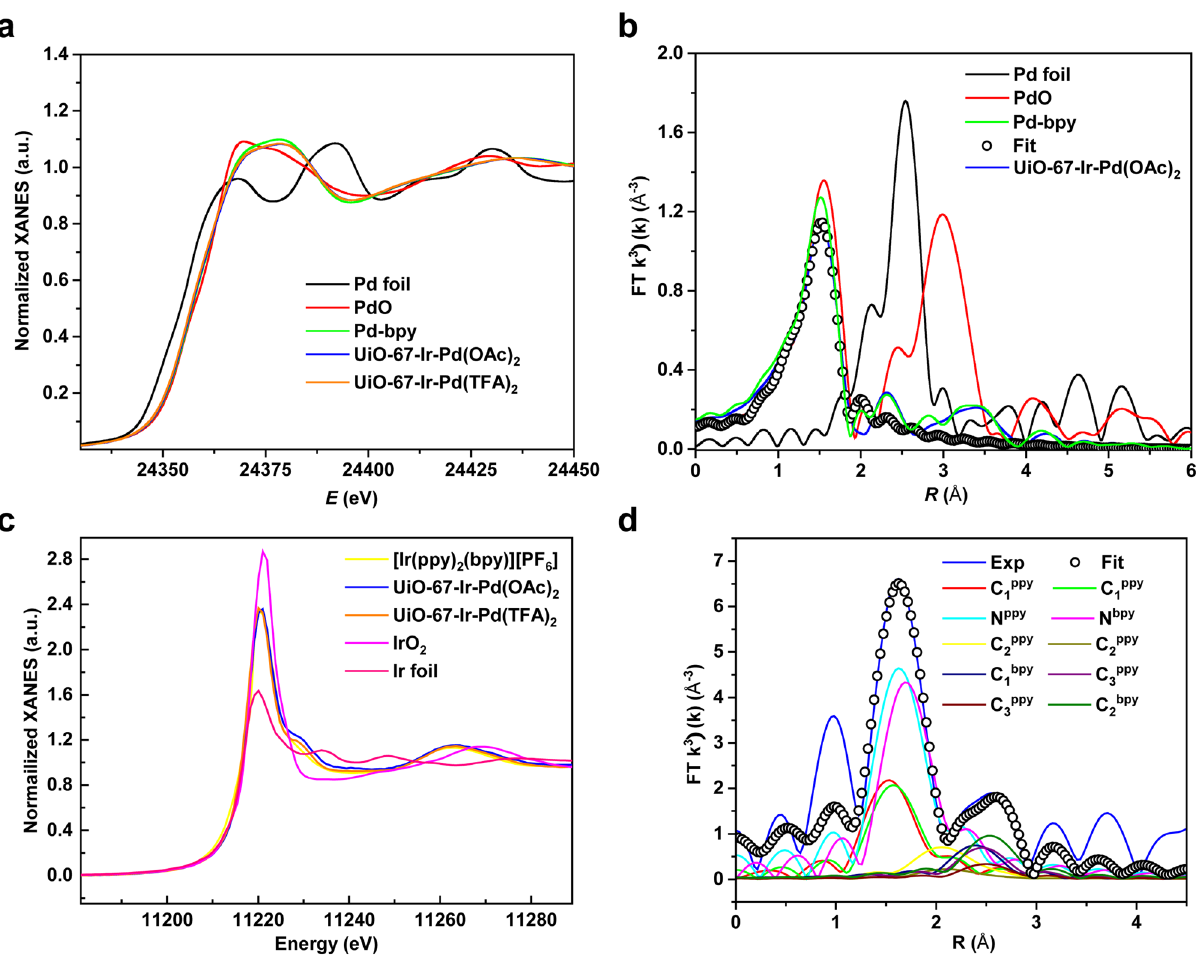
Fig. 3 XANES and EXAFS characteristics of UiO-67-Ir-Pd X 2 ( X = OAc, TFA). a Normalized XANES features of Pd foil (black), PdO (red), Pd-bpy (green), UiO-67-Ir-Pd(OAc) 2 (blue) and UiO-67-Ir-Pd(TFA) 2 (orange). b EXAFS spectra in R space at the Pd K-edge adsorption of Pd foil (black), PdO (red), Pd- bpy (green), and UiO-67-Ir-Pd(OAc) 2 (blue). c Normalized XANES features of Ir foil (pink), IrO 2 (magenta), [Ir(bpy)(ppy) 2 ](PF 6 ) (yellow), UiO-67-Ir- Pd(OAc) 2 (blue) and UiO-67-Ir-Pd(TFA) 2 (orange). d EXAFS spectrum (bule line) and fi t (black circles) in R space at the Ir L 3 -edge adsorption of UiO-67- Ir-Pd(OAc) 2